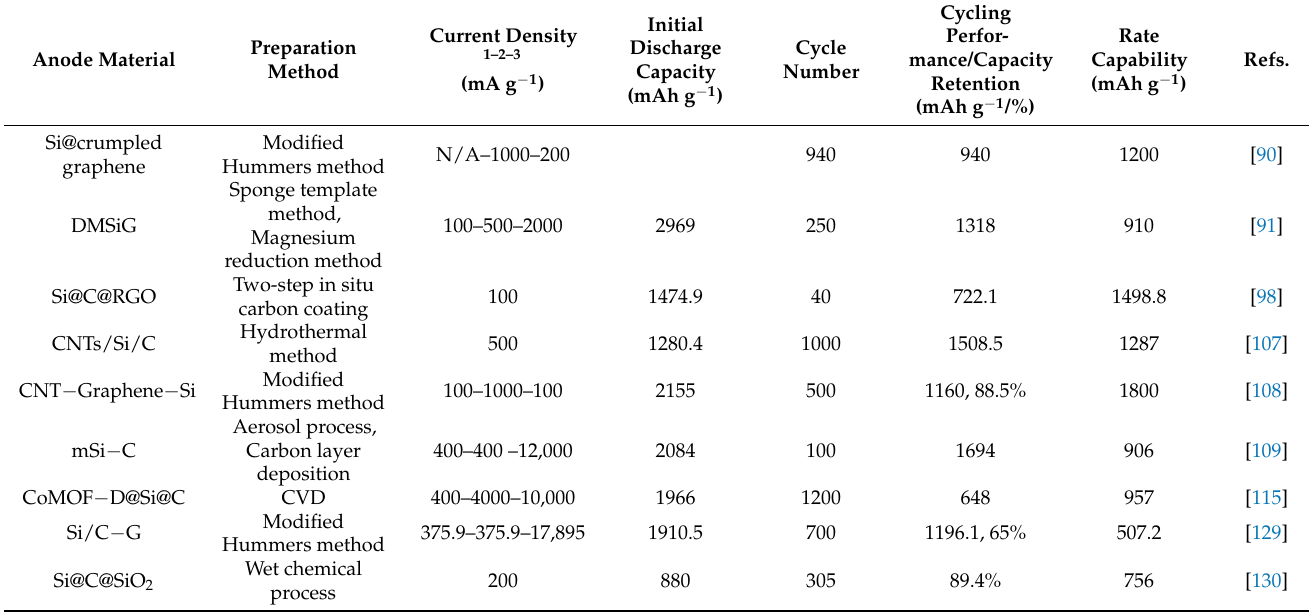
Table 1. Electrochemical performance of coated core-shell silicon/carbon anodes for